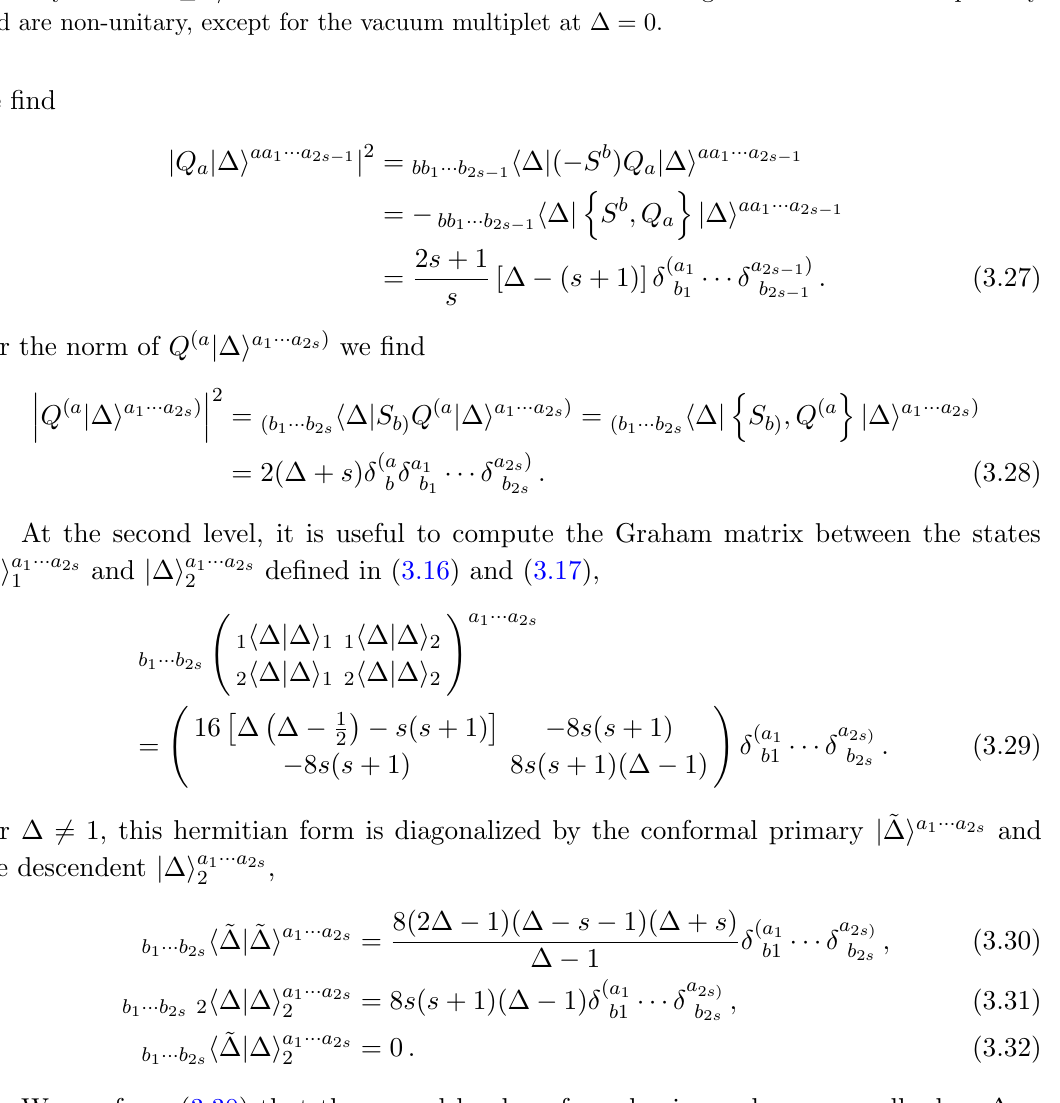
Figure 1 . Relative norms of the conformal primaries within the f 0 g values of (cid:1). Black is positive norm, red is negative norm, and green is zero norm. We see the unitarity bound (cid:1) (cid:21) 1 = 2. All the cases below this bound have a negative norm conformal primary and are non-unitary, except for the vacuum multiplet at (cid:1) =